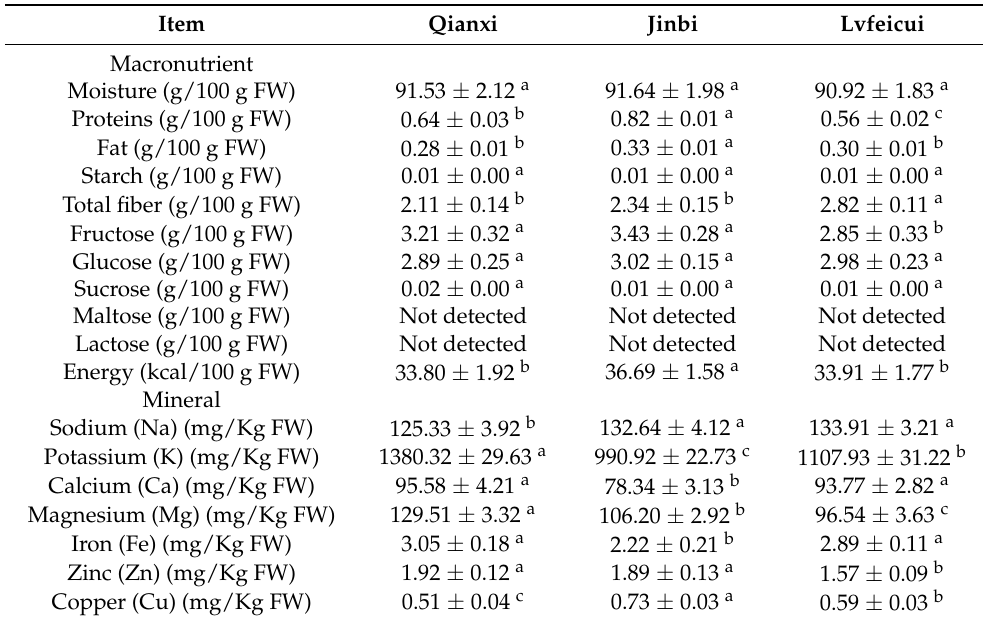
Table 2. Macronutrient and mineral composition of three different types of cherry tomatoes. Item Qianxi Jinbi Lvfeicui